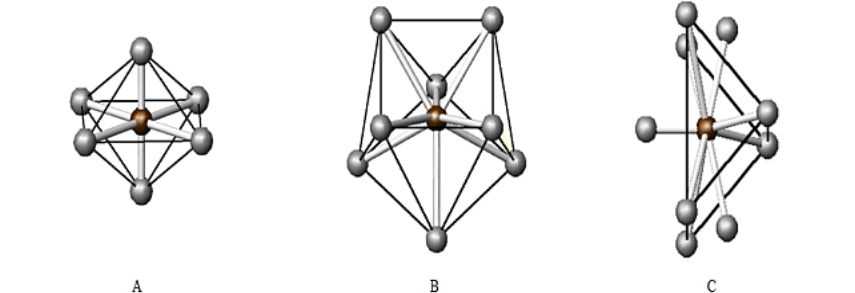
Fig. 5: The geometry structures for A: octahedron, (C.N.6), B: square antiprism, (C.N.8), and C: tricapped trigonal prism, (C.N.9) [24].